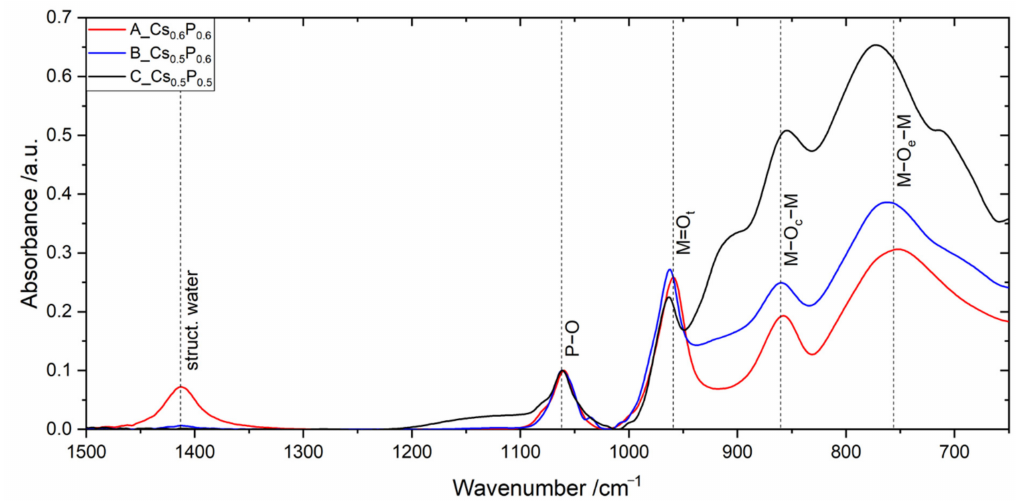
Figure 2. IR spectra of catalyst A_Cs 0.6 P 0.6, B_Cs 0.5 P 0.6 and C_Cs 0.5 P 0.5 normalized to the characteristic ( ν )-P-O-vibration at 1062 cm − 1 .